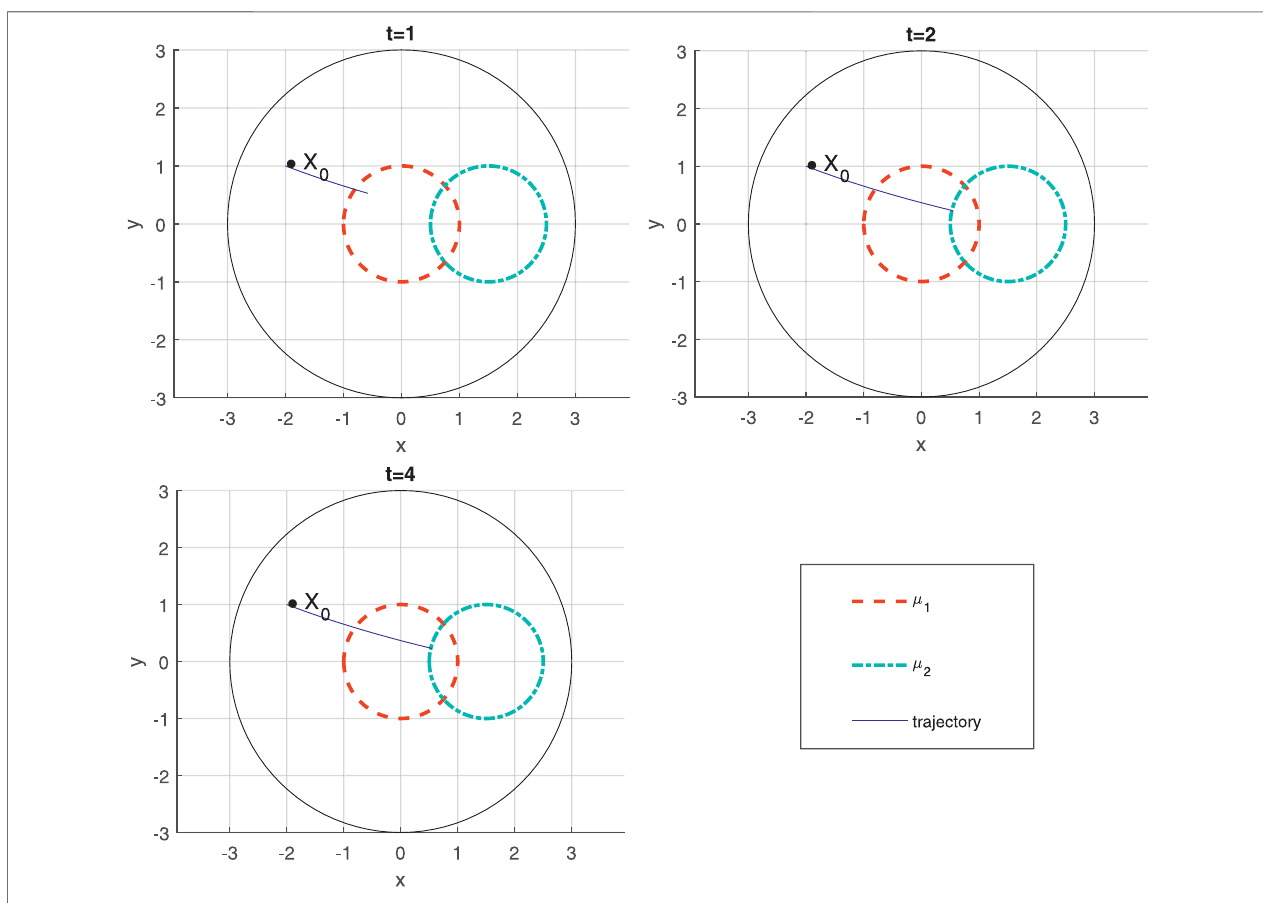
FIGURE 4 | Trajectory of the robot for STL task φ 2 ( 29 ) at different time instances, with time label at the top of each fi gure.